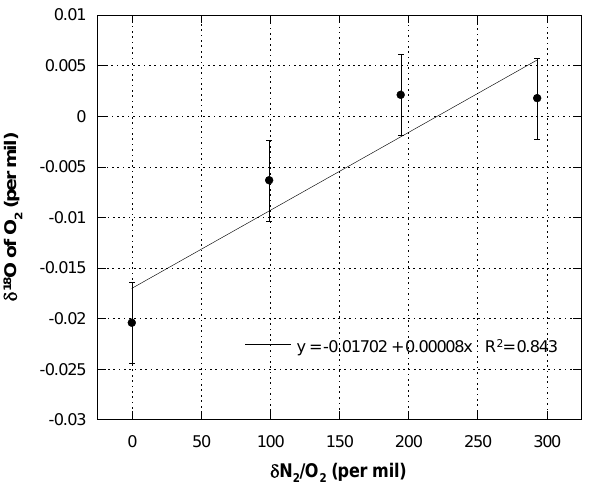
Fig. A1. Results of the “chemical slope” experiment used for cor- recting oxygen isotope data. Pure commercially-obtained N 2 was added to aliquots of an air standard. Note that N 2 is in the numer- ator in this plot. The resulting corrections applied to the data were 0 . 0006‰ or